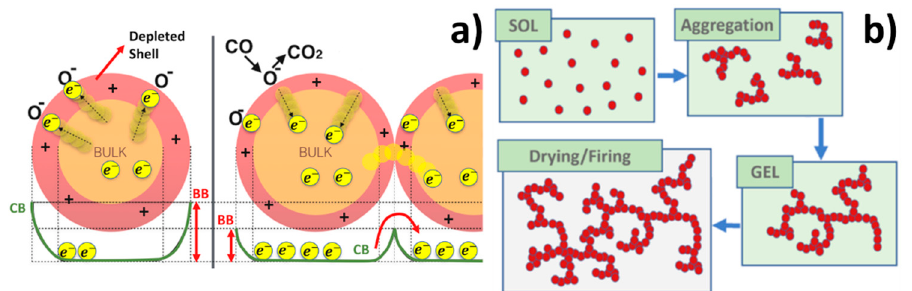
Figure 1. Synthesis and working principle of the MOX nanostructured thick film. ( a ) The four main steps of the sol-gel process producing interconnected networks of nanometric grains. ( b ) N-type sensor detection process to a reducing gas (CO). CB and BB are the conduction band and the band banding, respectively; yellow points represent electrons, orange circles the grain bulk, and the pink ring is the grain depletion region.